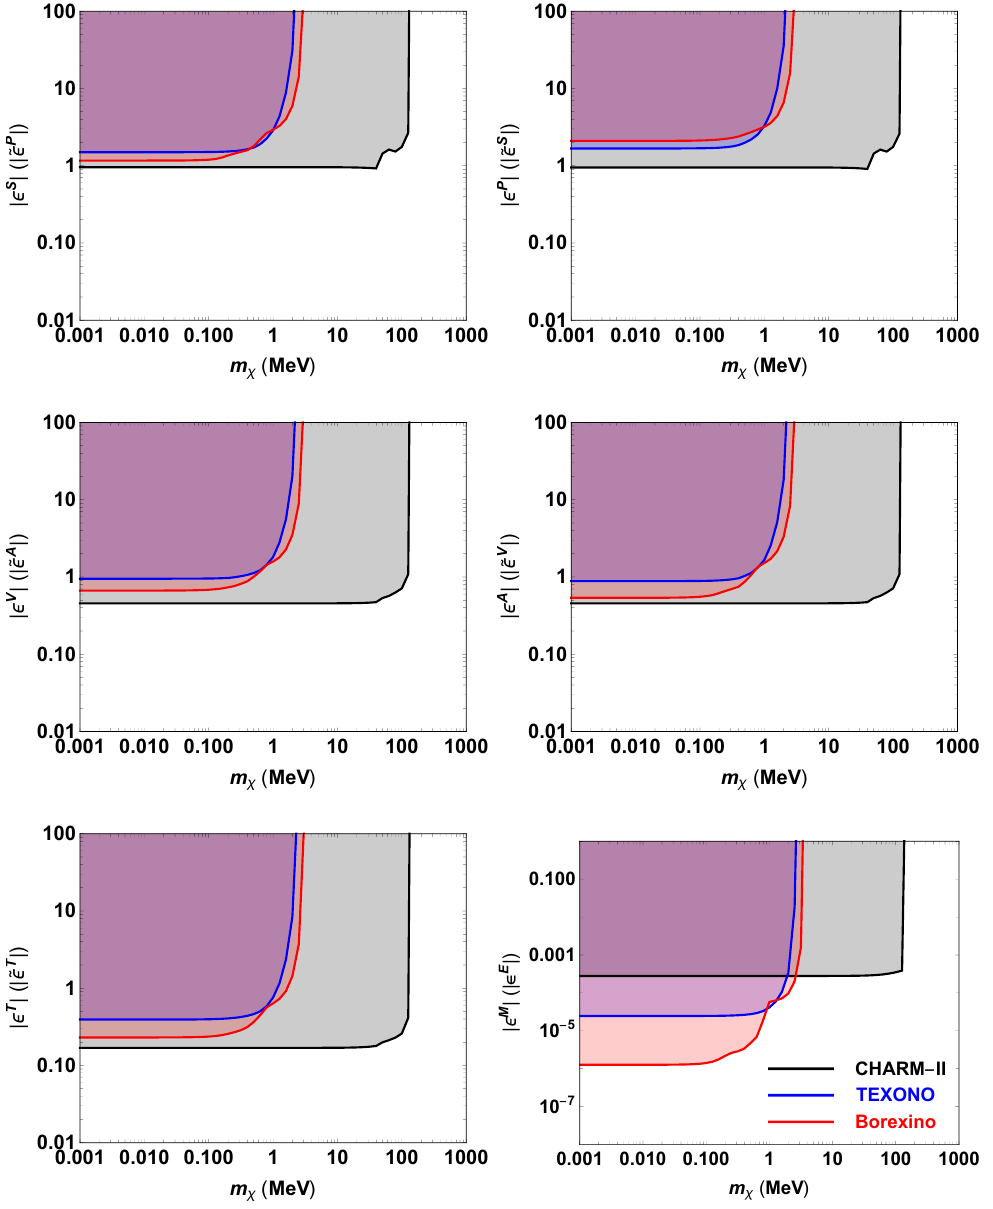
Figure 4 . The 90% CL upper bounds on the magnitude of coupling coefficients as a function of m χ for the scalar, pseudoscalar, vector, axialvector, tensor and electromagnetic dipole interactions. We assume that the couplings are flavor universal and only one (cid:15) i ( ˜ (cid:15) i ) exists at a time. The gray, blue and red shaded regions are excluded by the CHARM-II, TEXONO and Borexino experiment, re- spectively. The bounds on | ˜ (cid:15) S and | (cid:15) M | , α